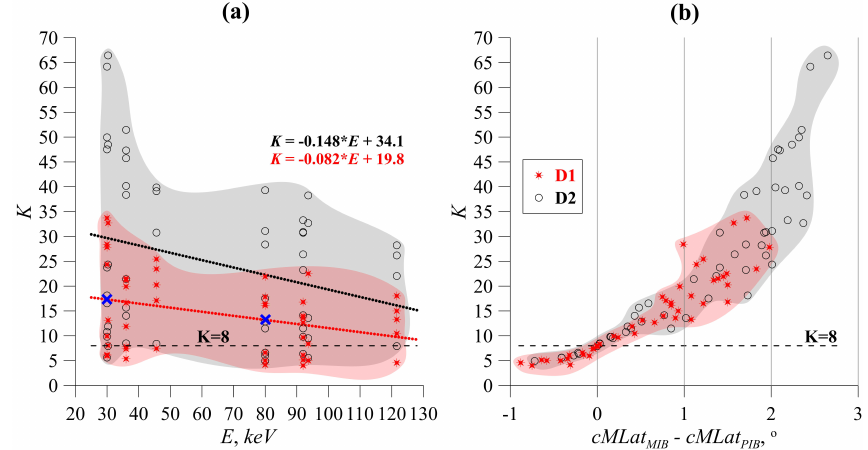
Figure 5. K distribution depending on (a) degradation-corrected lower energy of the proton channel and (b) latitudinal distance between PIB and equatorial point MOB where K = 8 (see Fig. 2a for the illustration).